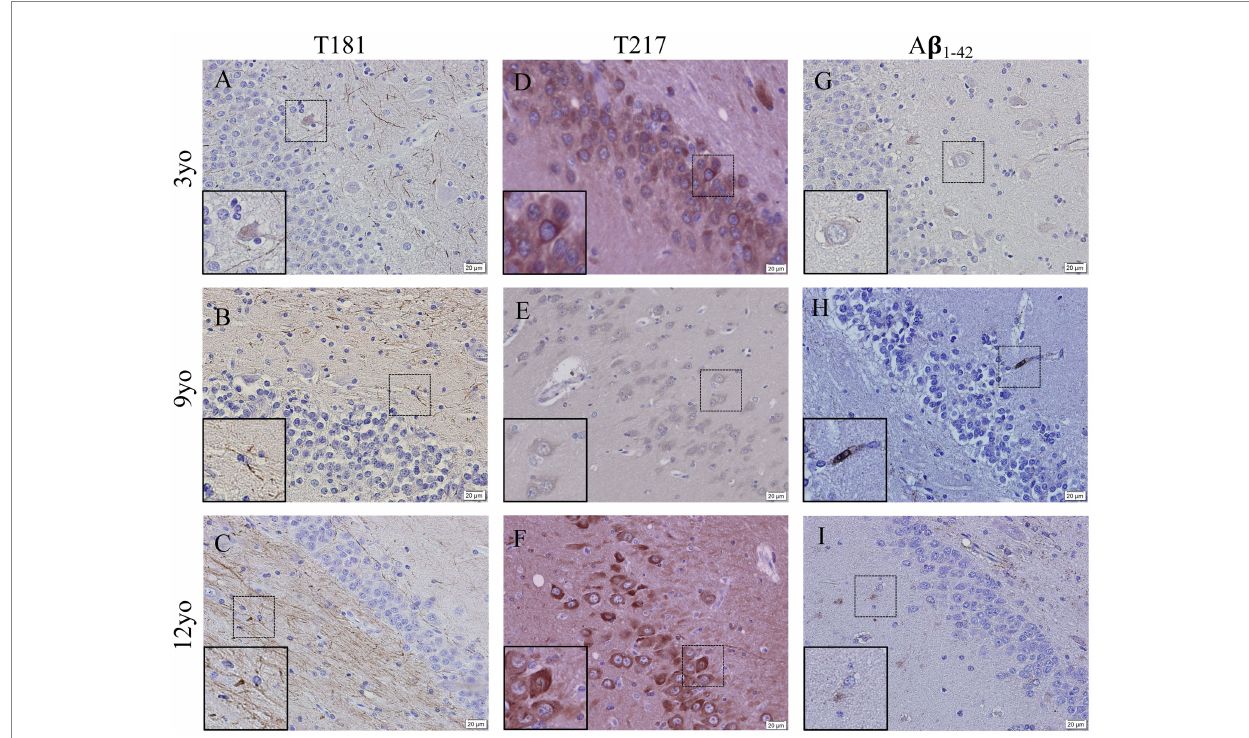
FIGURE 5 Hyperphosphorylation of Tau and Amyloid β 1-42 accumulation in the hippocampus of young and aging canines. Representative images of young (3 years of age; n = 5) and aged (8 years of age and older; n = 41) canines are shown. Phosphorylated threonine 181 tau is increased at 9 (B) and 12 years of age (C) compared to young canines (A) . Phosphorylated threonine 217 tau is present at 3 years of age (D) and at 12 years of age with distinct intracellular deposits at 12 years of age (F) and very little staining at a different dog at 9 years old (E) . A β 1-42 accumulates in the 9 (H) year old dog, more than the 3 year old (G) and 12 year old dog (I) . Scale bar = 20